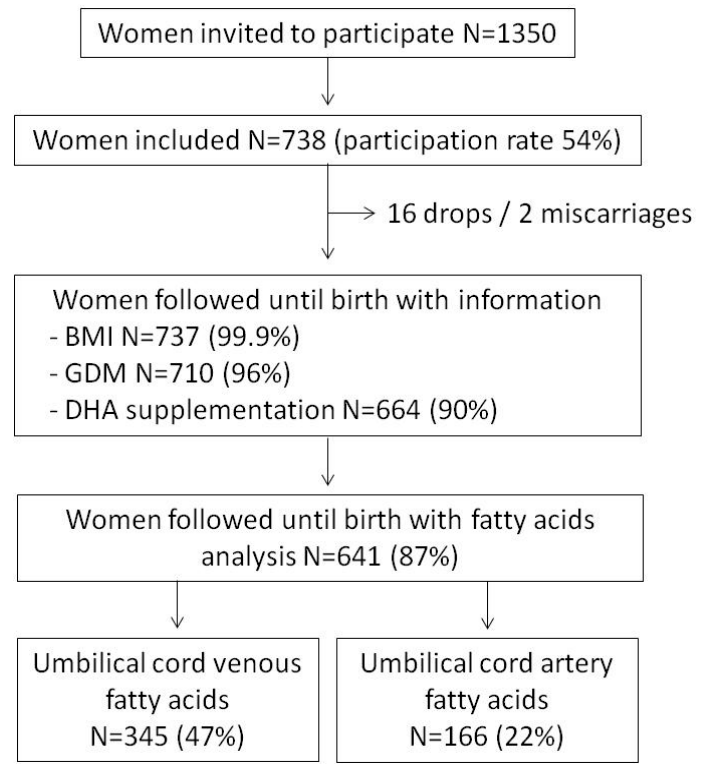
Figure 1. Flow diagram of the study.